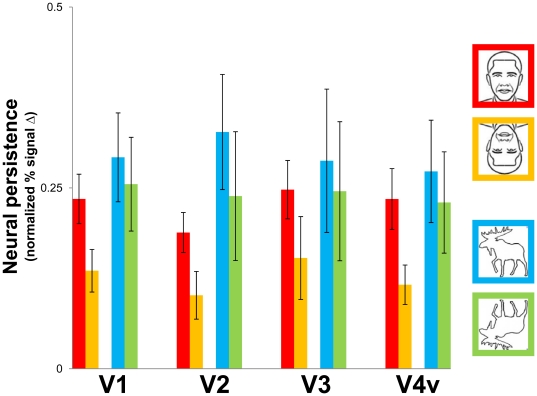
Persistence-related activity in early visual areas.Neural persistence was higher for upright faces and animals than their inverted counterparts, in all early visual ROIs. These fMRI results closely resemble those shown in Figure 5b and the behavioral results in Figure 2. Error bars show the standard error (SE) for the group (n = 10).